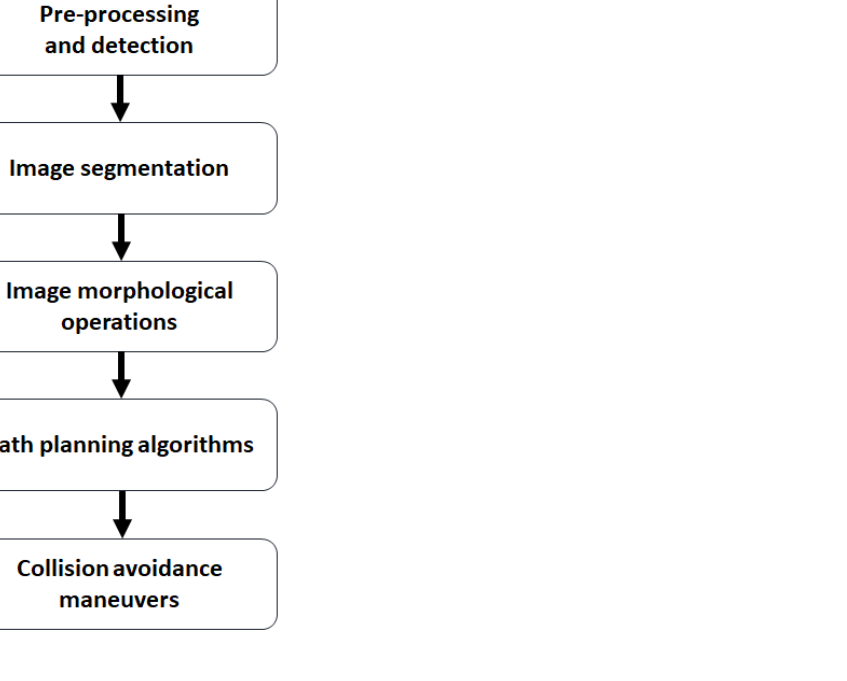
Figure 1. Workflow of ODS operations in conjunction with path planning and collision avoidance algorithms. The image of the environment obtained as a result of the detection is processed using image processing techniques. Then the AUV movement path is determined depending on the position of obstacles and collision avoidance maneuvers are performed, taking into account the design constraints of the